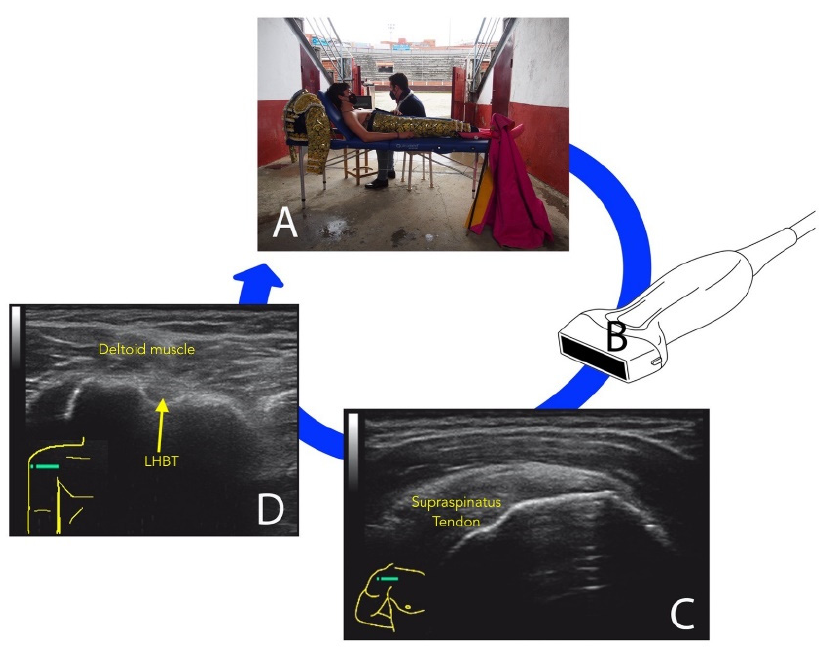
Figure 1. Ultrasound assessment of bullfighters ( A ) with a linear transducer ( B ). Image acquisition of supraspinatus tendon ( C ) and long biceps head tendon (LBHT) ( D ). The rotator cuff was examined for assessing the tendon thickness, partial or total ruptures, bursitis, and calcifications. Rotator cuff tendon tears were indicated by the existence of visible gaps or total absence of tendon tissue in the subacromial space, while calcifications were identified as hyperechoic shapes with posterior acoustic shadows located in the tendon matrix [21]. After examining the LHBT, participants were asked to place the shoulder into a further external rotation for examining the subscapularis tendon between the scapular coracoid process and the humeral lesser tubercle [22]. For examining the supraspinatus tendon, participants were placed in a modified “crass position” with the hand placed on the low back with the elbow flexed, placing the probe in a longitudinal plane for assessing the supraspinatus tendon between the scapular acromial process and the humeral greater tubercle [23]. Subdeltoid bursa was assessed as well in this position; a bursitis diagnosis was considered if thickness was +2 mm [24]. Finally, the imaging of the infraspinatus tendon was made in the same position with the shoulder slightly internally rotated and gliding the transducer to the longitudinal and the transversal planes on the dorsal aspect of the